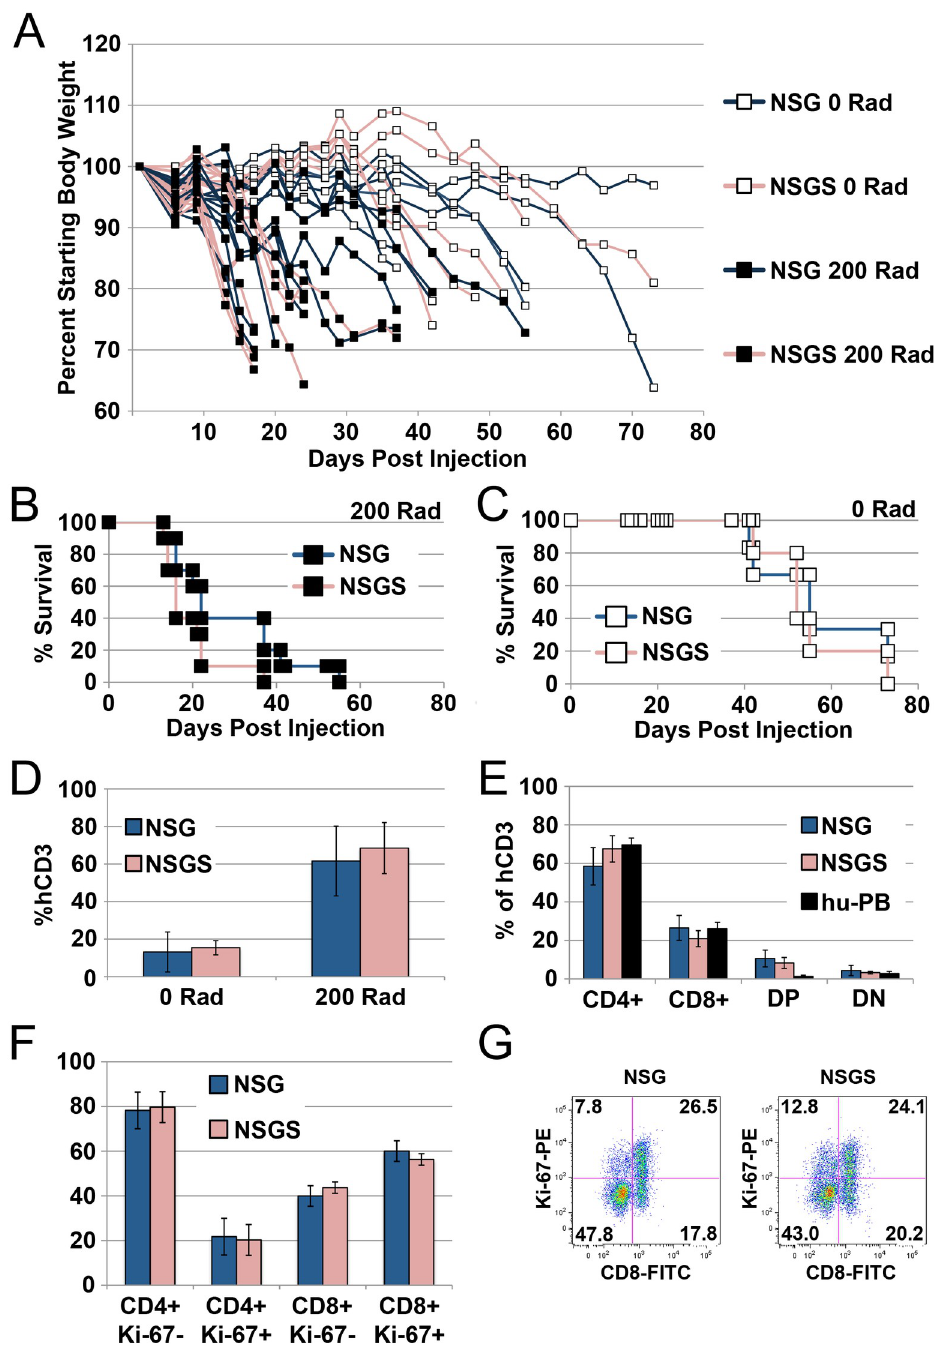
Fig 7. Mature T cells expand similarly in NSG and NSGS as shown by GVHD models. A) Individual mouse weights over time after tail vein injection of adult PB MNCs. NSG (blue lines) and NSGS (red lines) experience weight loss with similar kinetics. Conditioned mice (filled boxes) show weight loss before non-conditioned mice (open boxes). B-C) Survival of the mice in panel A. D) Levels of CD3+ T cells in mice at 2 weeks. E) Levels of CD4 and CD8 cells at 2 weeks. F) Ki-67 staining reveals no changes in the cycling of either CD4 or CD8 T cells between strains. G) Representative plot used to generate panel F.